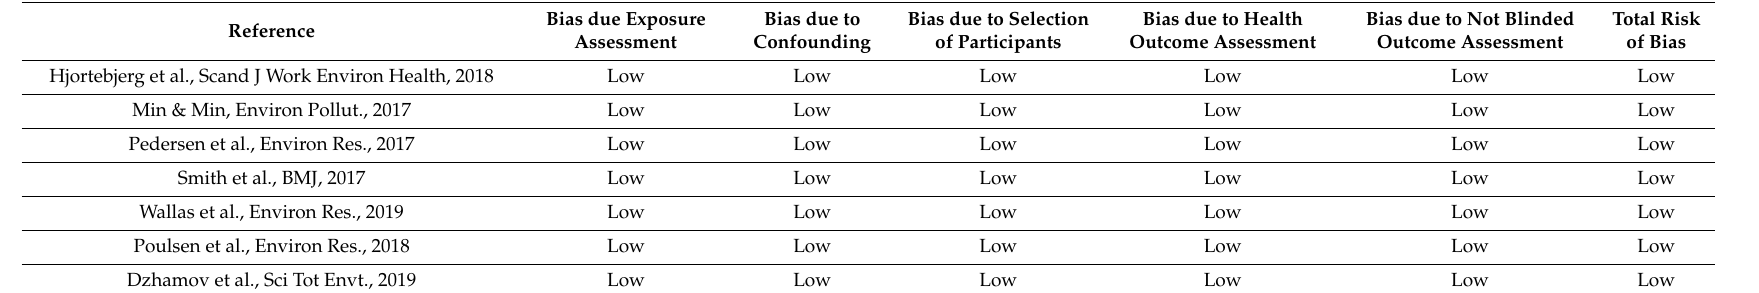
Table 5. Birth and reproductive outcomes: risk of bias.